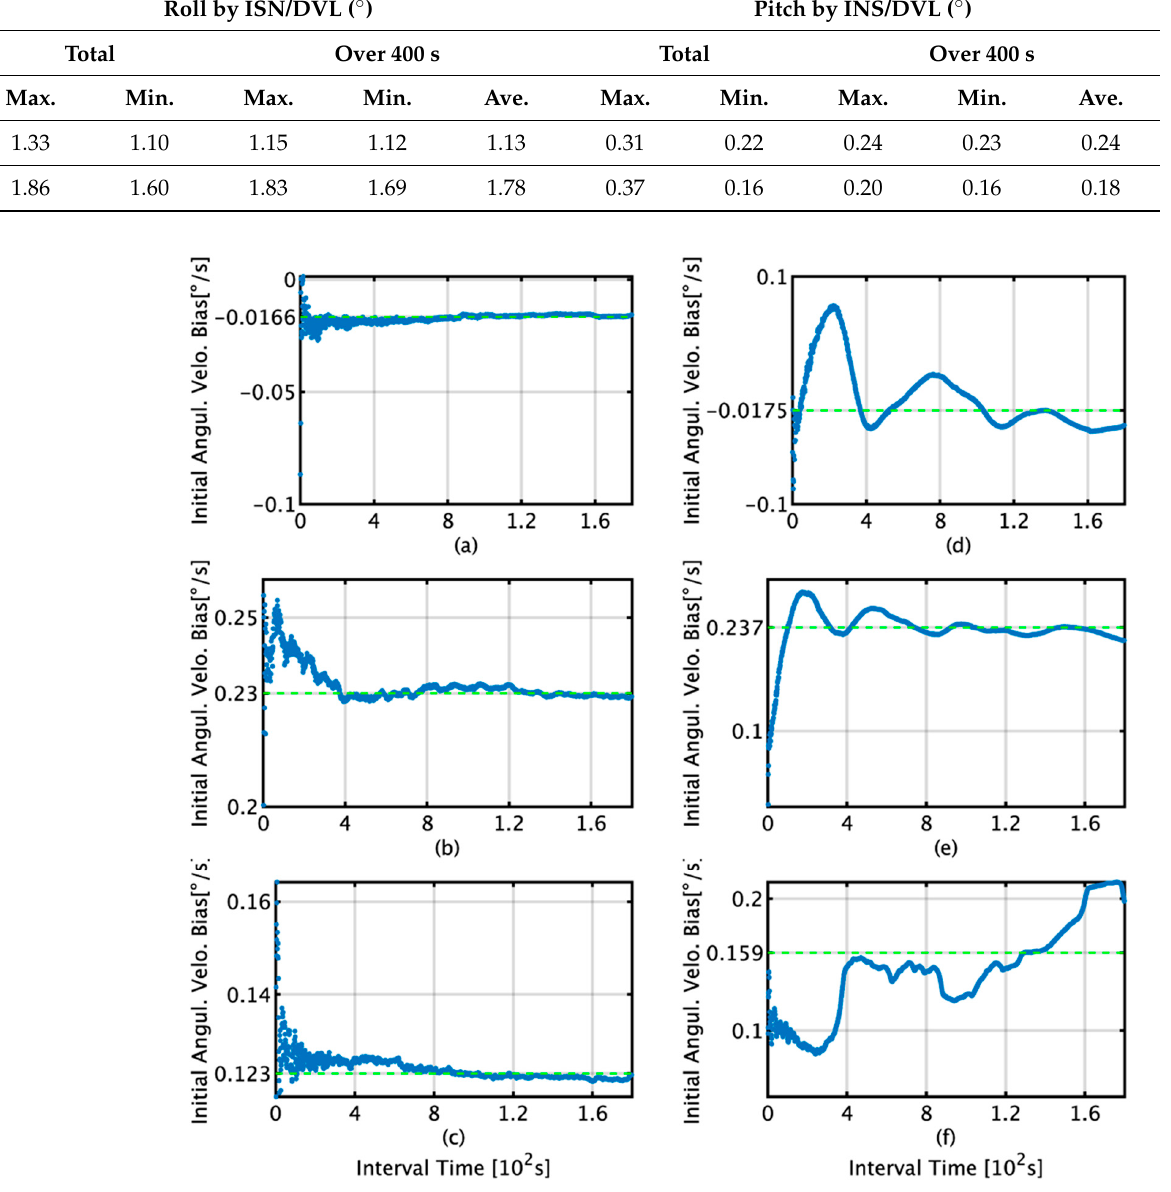
Figure 9. Initial bias estimates and data interval relationships obtained by the TG and KF for angular velocity; ( a ) x -axis angular velocity bias by TG; ( b ) y -axis angular velocity bias by TG; ( c ) z -axis angular velocity bias by TG; ( d ) x -axis angular velocity bias by KF; ( e ) y -axis angular velocity bias by KF; ( f ) z -axis angular velocity bias by KF.